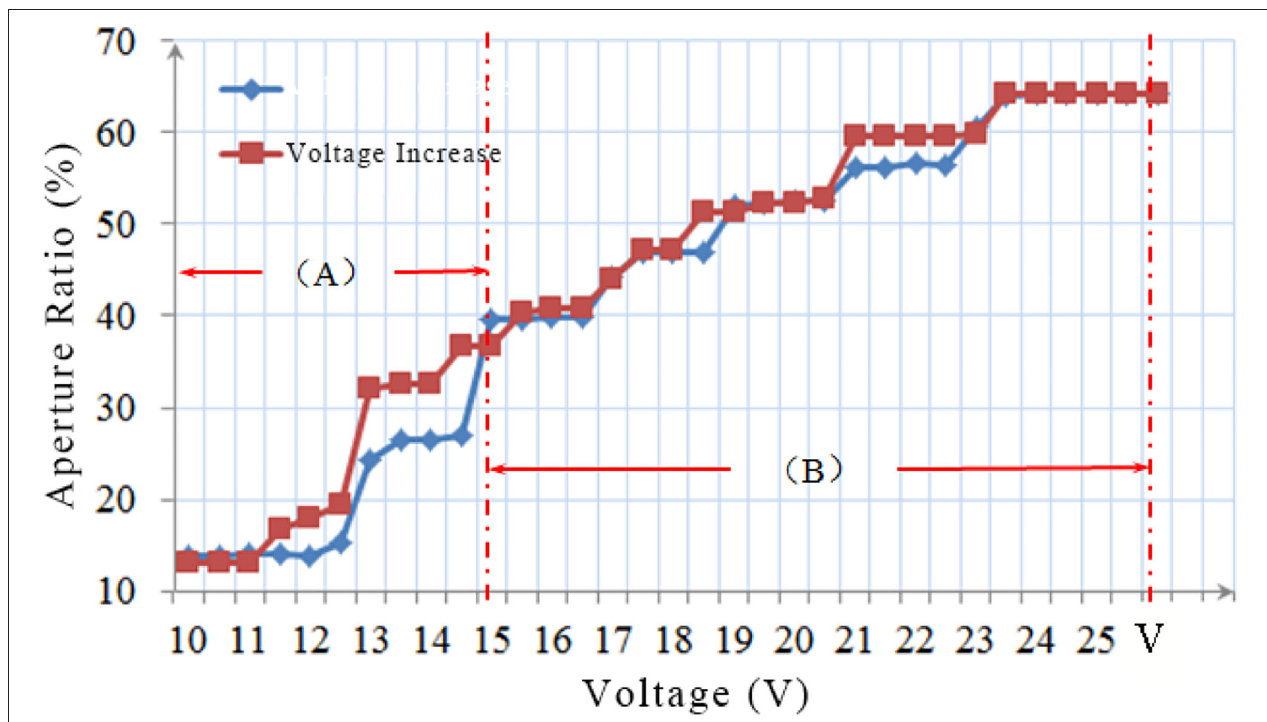
FIGURE 9 | Hysteresis characteristic curves of an EWD driven by a 470Hz AC driving voltage. The red curve represented the aperture ratio when the driving voltage was increased from 10 to 25V, the blue curve represented the aperture ratio when the driving voltage was decreased from 25 to 10V. The maximum distortion is 5.97%. (A) Indicates the state where the difference of aperture ratio changes greatly, (B) indicates the stage where the difference of aperture ratio changes little.